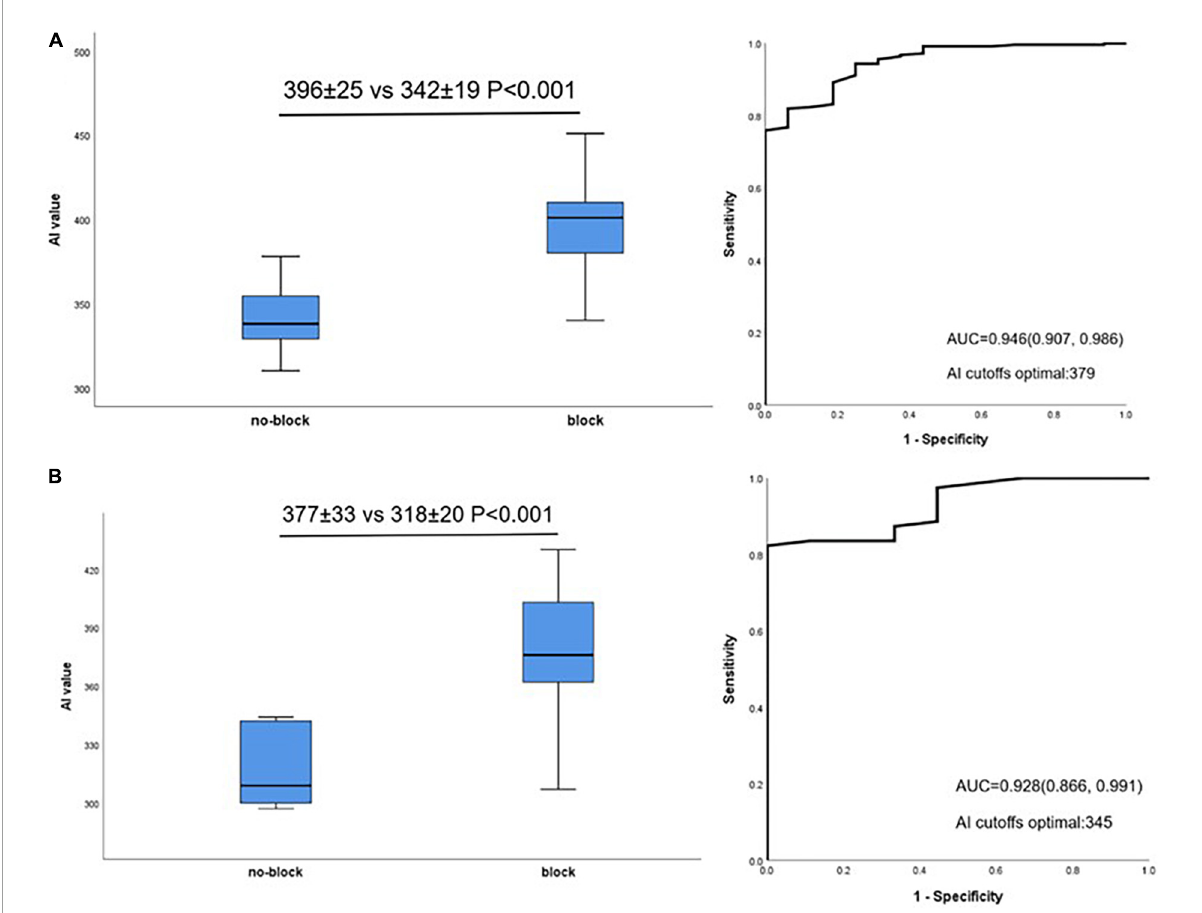
FIGURE4 Relationship between AI value and acute block after first-pass encirclement. (A) Mean AI value in non-lateral segments acutely blocked and no-blocked sites (Left) and corresponding ROC curve analysis (Right). (B) Mean AI value in lateral segments acutely blocked and no-blocked sites (Left) and corresponding ROC curve analysis